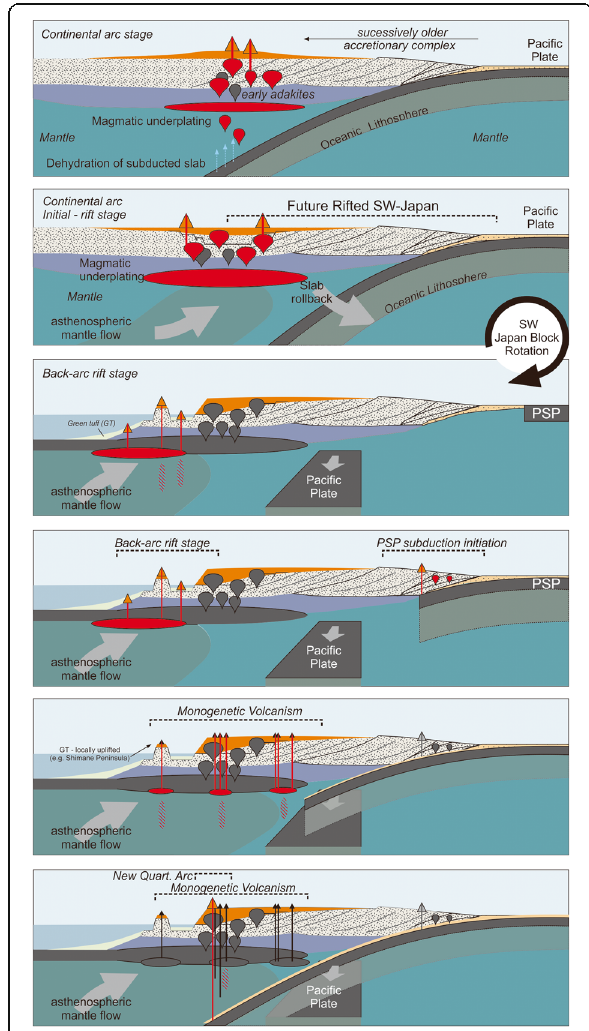
Fig. 14 Synopsis of the tectonic and igneous evolution in the SW Japan